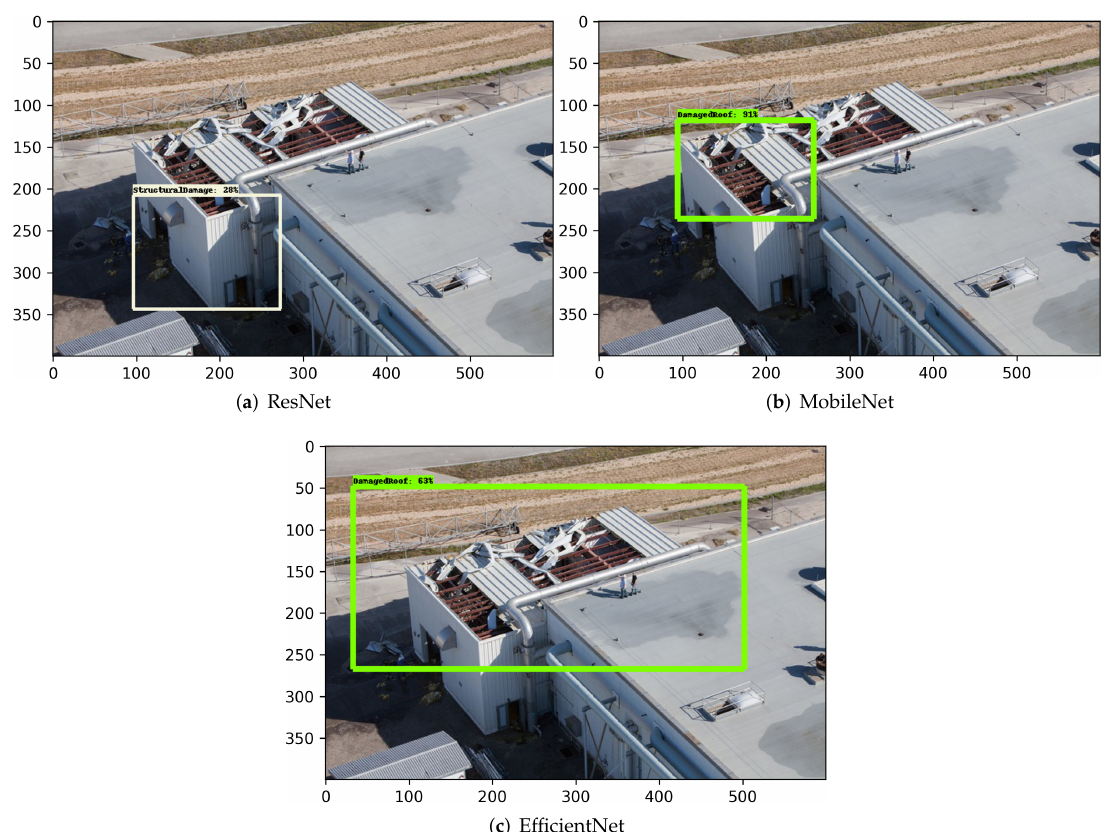
Figure 6. Inference carried out on the image of a damaged roof for each of the three models. The green bounding boxes correspond to the correct predictions of a damaged roof , and the grey bounding box corresponds to the incorrect prediction of structural damage from the first row of Table 4.